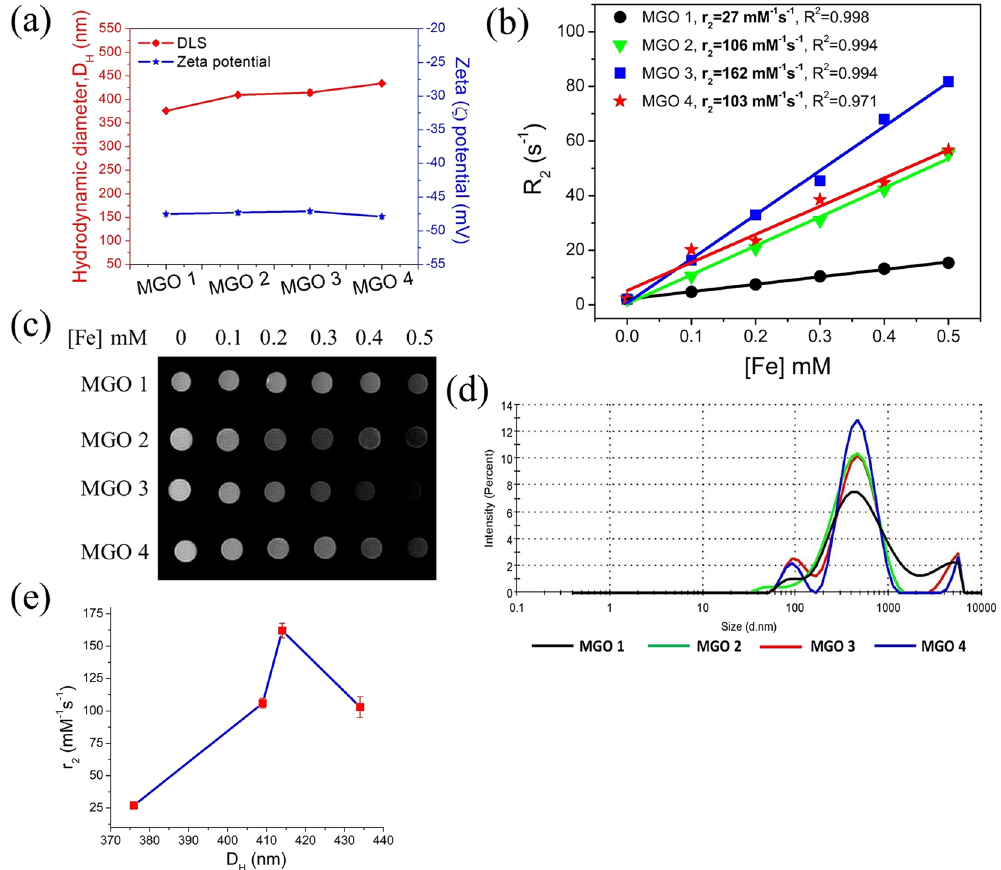
Figure 6. ( a ) Dynamic light scattering (DLS) and Zeta potential, ( b ) MR transverse relaxivity (r 2 ) measurements, ( c ) MR in vitro phantom images, ( d ) DLS size (D H ) distribution profile of MGOs and ( e ) r 2 values with respect to D H of